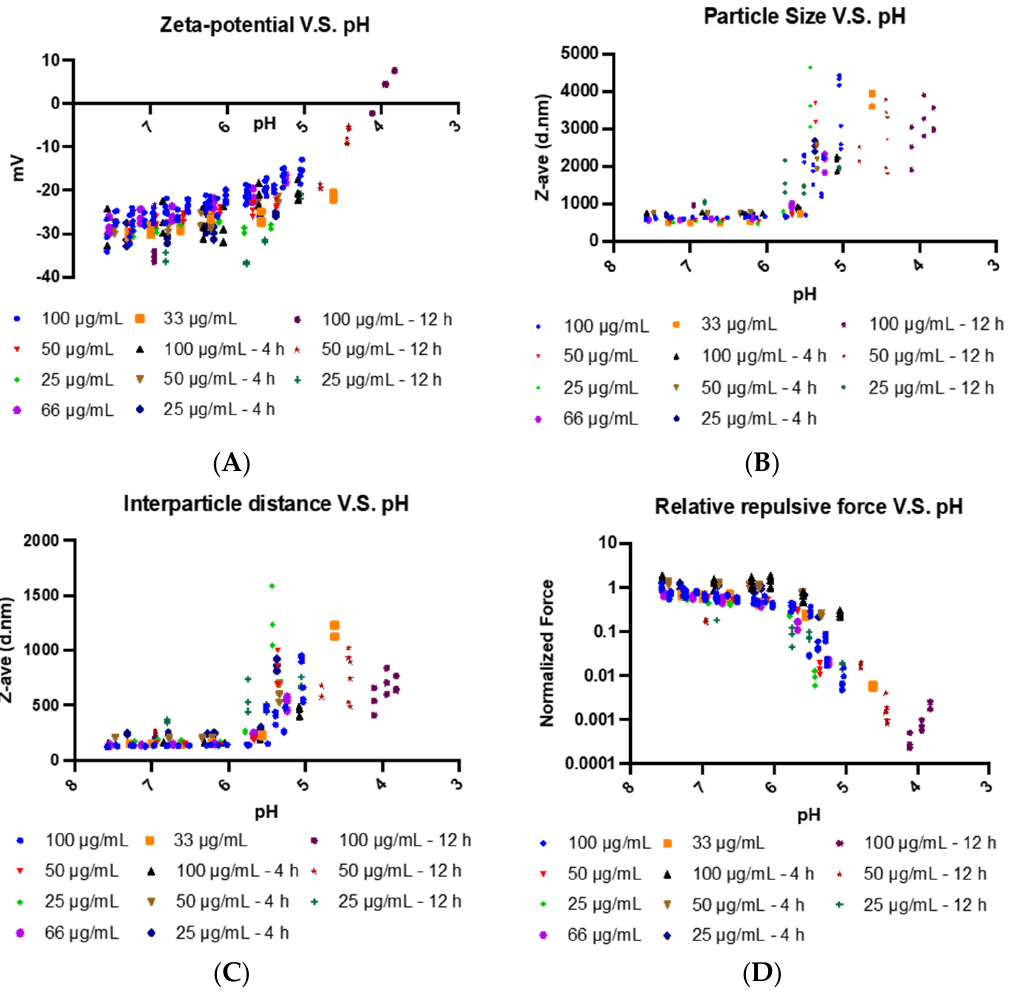
Figure 4. As the pH decreases and the environment becomes more acidic: ( A ) zeta-potential in- creases; ( B ) particle size increases at pH < 6; ( C ) interparticle distance increases at pH < 6; and ( D ) relative repulsive forces slowly decrease at pH < 6 and decrease much faster at pH < 5.